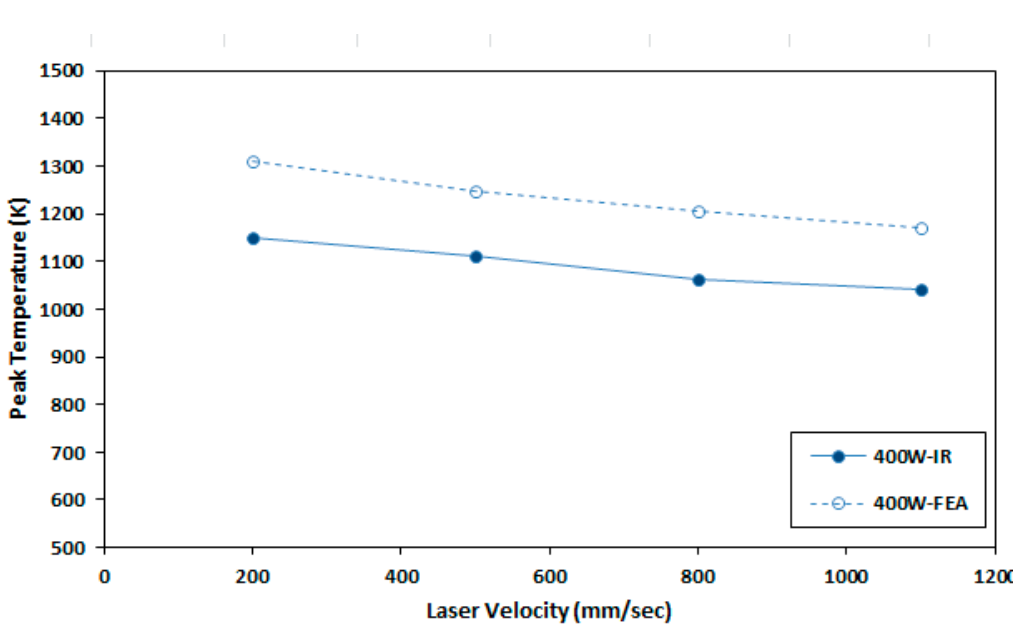
Figure 5. Comparison of maximum FEA temperature that is averaged over a camera pixel and IR data of Ti-64 sample at 400 W and 200 to 1100 mm / s.